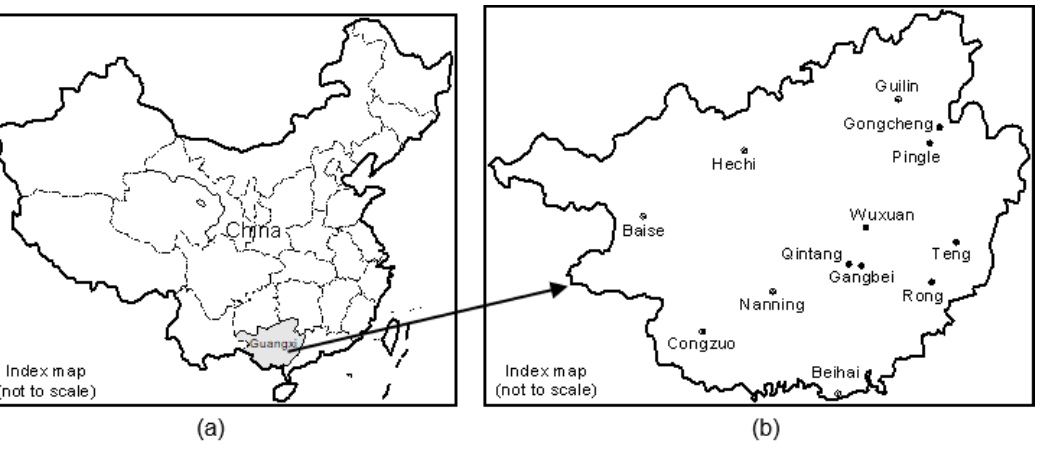
Figure 1. Map showing the location of FSM application in Guangxi study area. ( a ) The location of the study province in China. ( b ) The enlarged map of the study province.